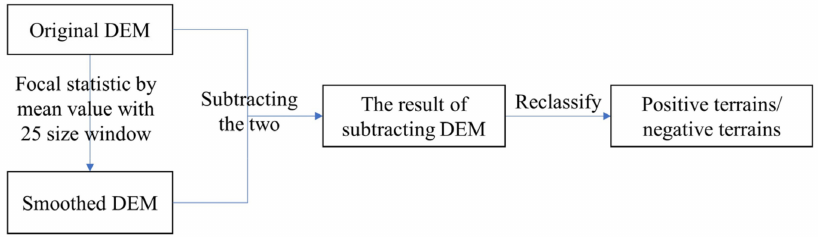
Figure 6. The process for positive and negative terrain divisions.